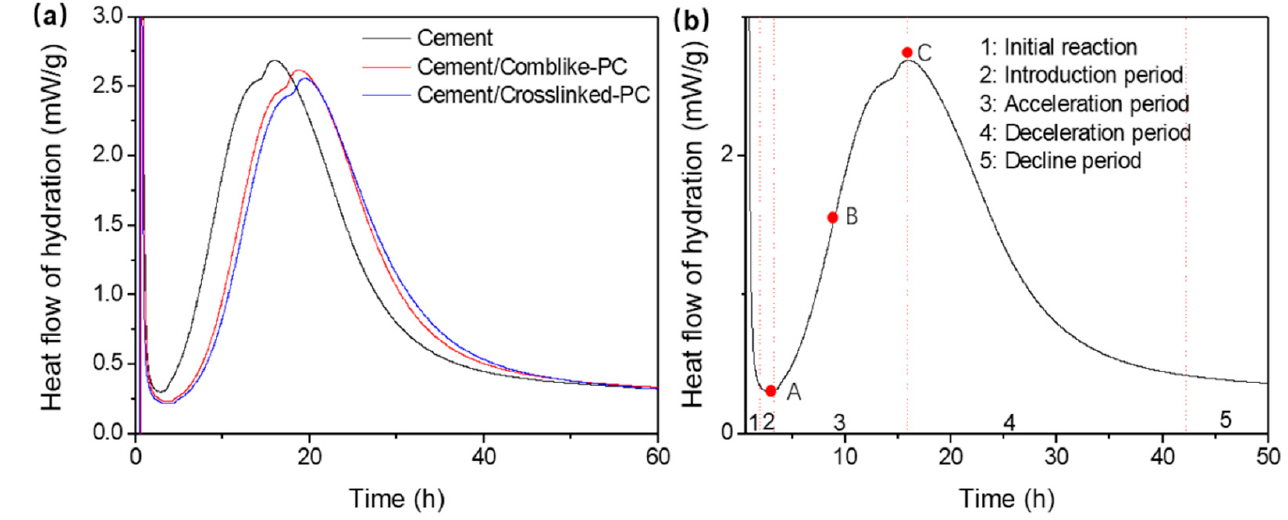
Figure 8. The hydration exothermic heat flow curves of cement/PC samples (0.5% bwoc) ( a ) and blank cement samples ( b